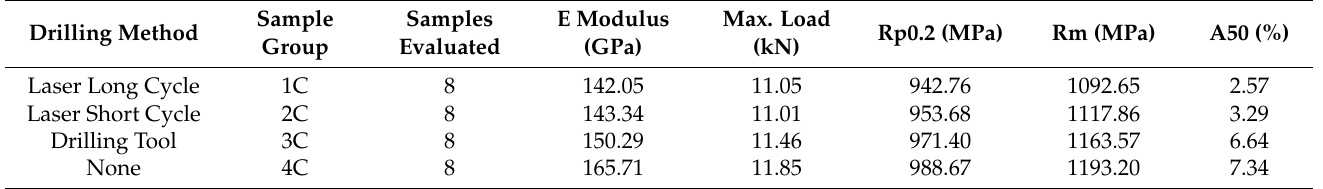
Table 11. Average values of mechanical properties—Inconel 718; material thickness 1.6 mm; tests at elevated temperature. Figure 15. Fracture areas and fracture surfaces of individual sample groups—material thickness 0.5 mm; tests at elevated temperature.